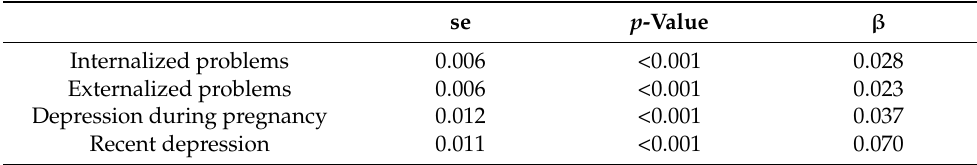
Table 6. Indirect effects through parental stress on externalized